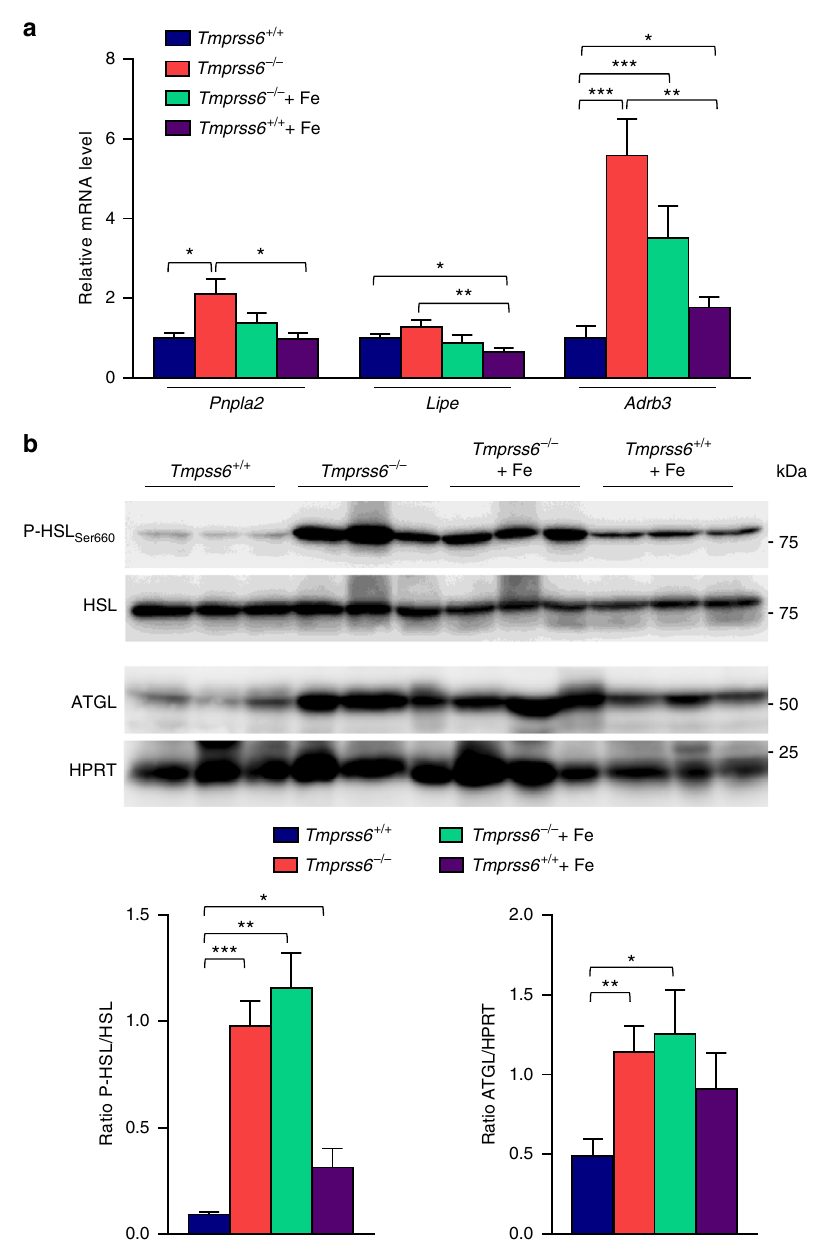
Fig. 5 Increased WAT lipolysis in mice lacking matriptase-2 upon HFD feeding. a Relative expression levels of genes related to lipolysis in WAT samples from HFD-fed Tmprss6 + / + ( n = 11), Tmprss6 − / − ( n = 7), and both iron-treated Tmprss6 − / − and Tmprss6 + / + mice ( n = 11 and n = 8, respectively). b Western-blot analysis of phospho-HSL(Ser660), total HSL and ATGL protein expression in WAT samples from HFD-fed Tmprss6 + / + ( n = 6), Tmprss6 − / − ( n = 6), and both iron-treated Tmprss6 − / − and Tmprss6 + / + mice ( n = 6 and n = 7 respectively). (top) A representative result showing increased phospho-HSL and ATGL protein levels in Tmprss6 − / − and both iron-treated Tmprss6 − / − and Tmprss6 + / + mice compared to wild-type mice. (bottom) Quanti fi cation of phospho-HSL protein levels relative to total HSL levels and ATGL protein levels relative to loading control HPRT (hypoxanthine- guanine phosphoribosyltransferase). Note that phospho-HSL and the corresponding loading control, the total HSL protein, were detected on the same samples run in parallel in two identical blots. Data shown are mean ± SEM. * P < 0.05, ** P < 0.01, *** P < 0.001, two-tailed Student ’ s t test